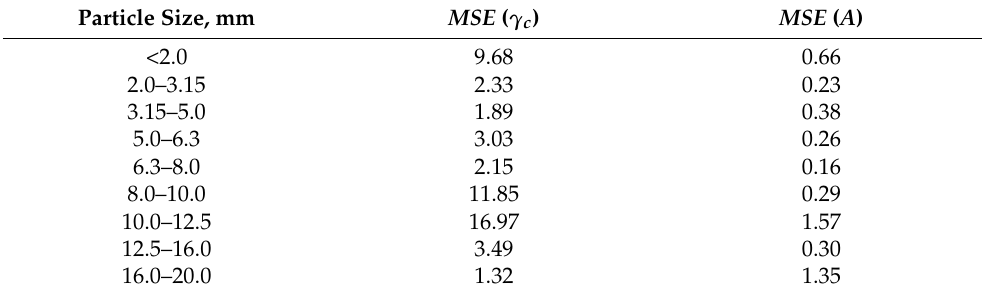
Table 3. The MSE value defines the average deviation of the model from the empirical